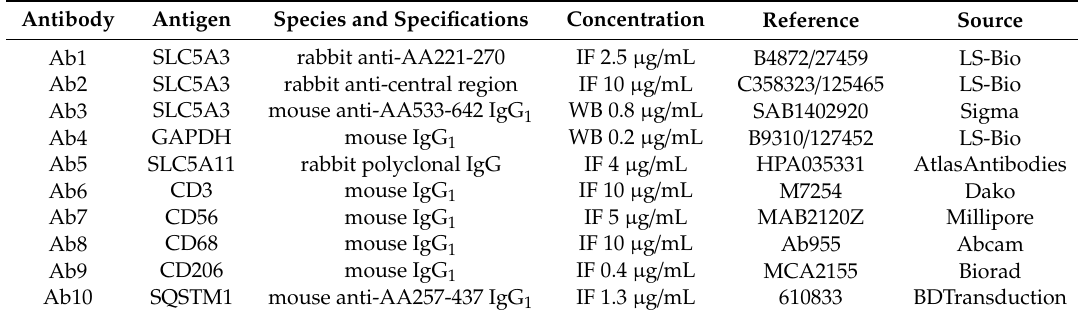
Table 2. Antibodies used for immunofluorescence (IF) and Western blotting